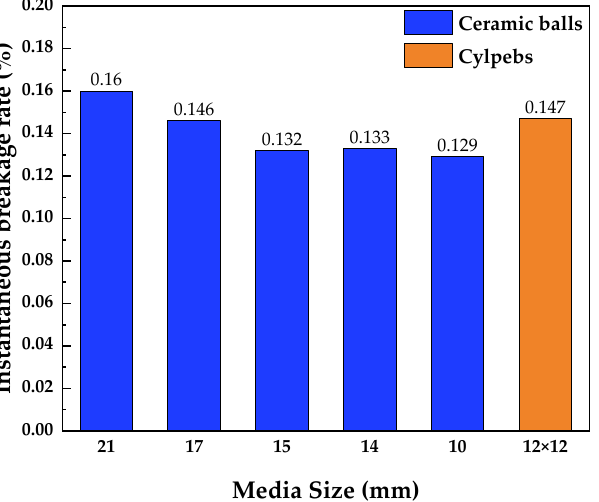
Figure 8. Instantaneous breakage rates of the ground products at the same total surface area.